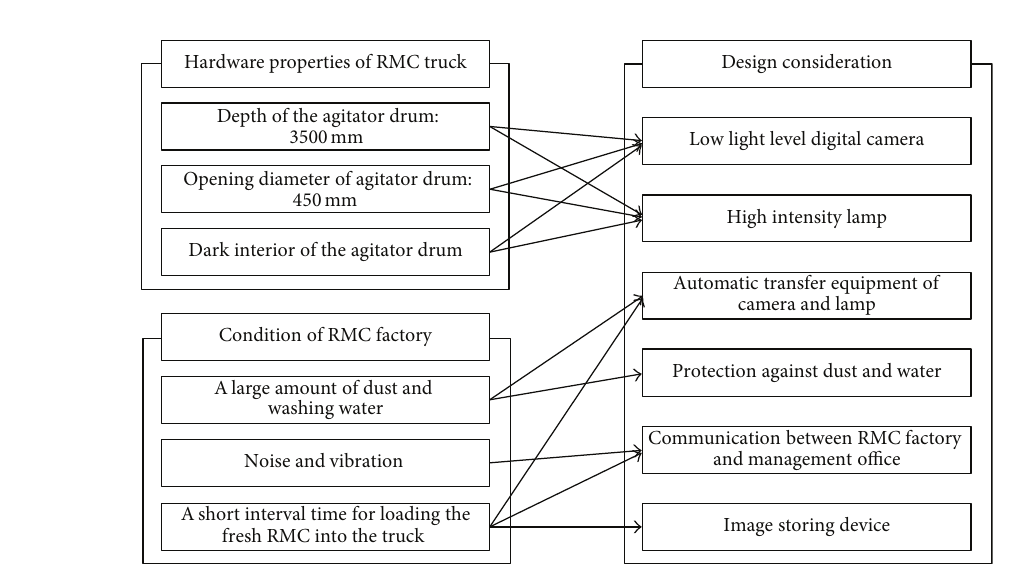
Figure 3: The major design considerations of the proposed